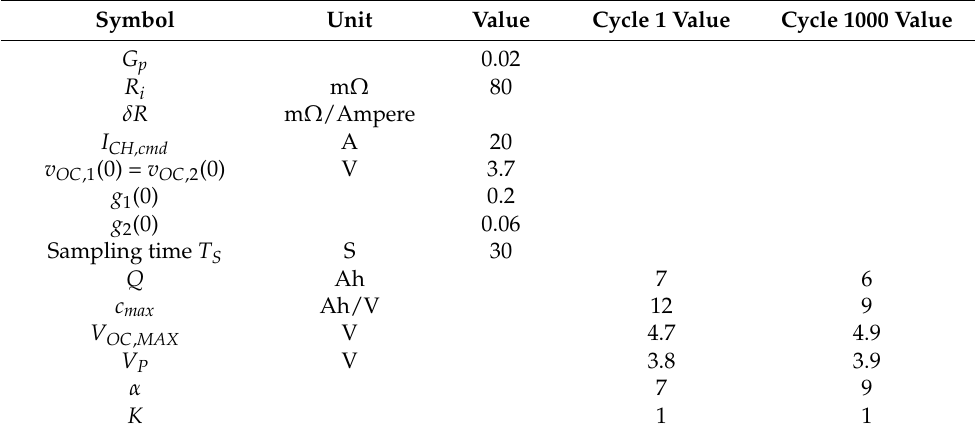
Table 3. Parameters used in the constant current charging